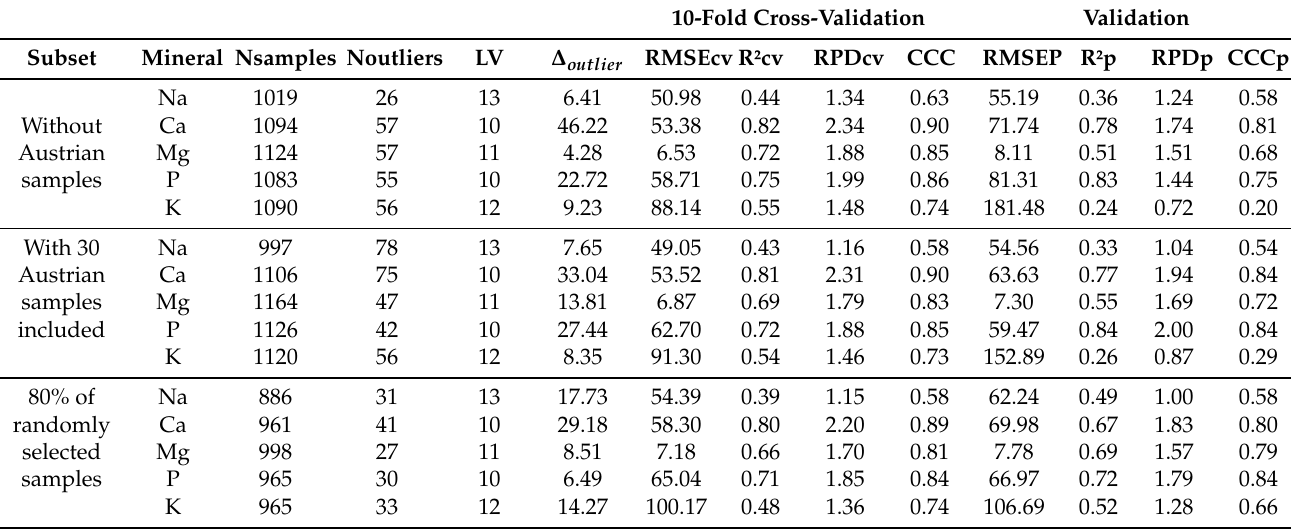
Table 3. Prediction performances of equations allowing to predict the content (mg/kg of milk) of major minerals in bovine